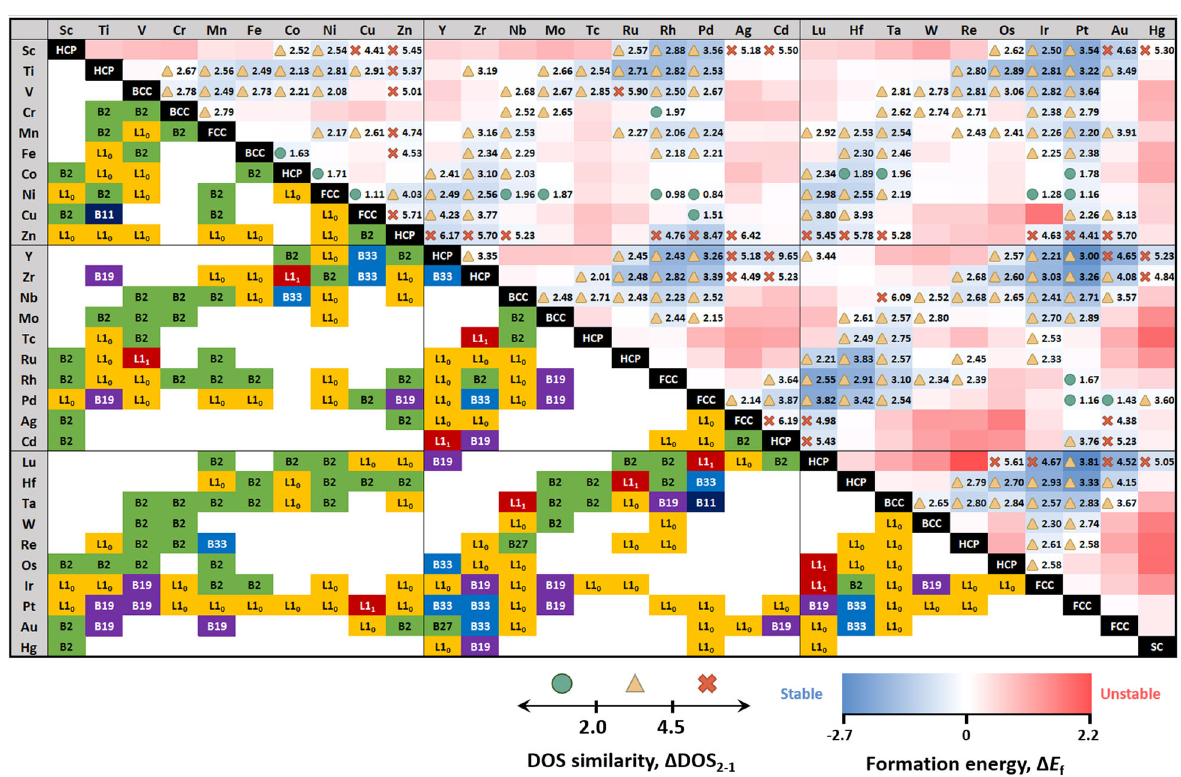
Fig. 3 Map of the thermodynamic stabilities and DOS similarities of bimetallic alloy systems. The diagonal components denote the most thermodynamically stable crystal structures (e.g., FCC, BCC, HCP, and SC) of pure metals. The occupied components under the diagonal denote the most thermodynamically stable crystal structures (e.g., B2, B11, B19, B27, B33, L1 0 , and L1 1 ) of bimetallic alloys. The background colors above the diagonal describe the formation energies, and the occupied components above the diagonal denote the DOS similarity of each alloy compared with